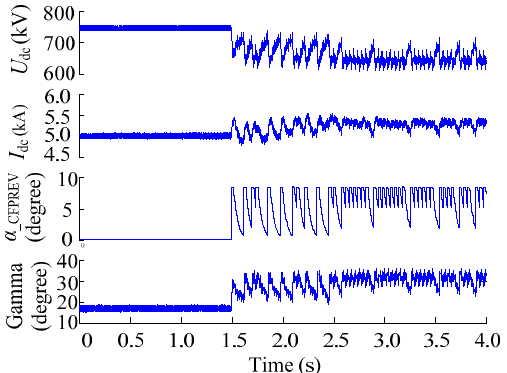
Figure 12. Reproduction of the disturbance due to the transformer excitation current recorded at the GuanDu substation and the traditional commutation failure prediction algorithm.